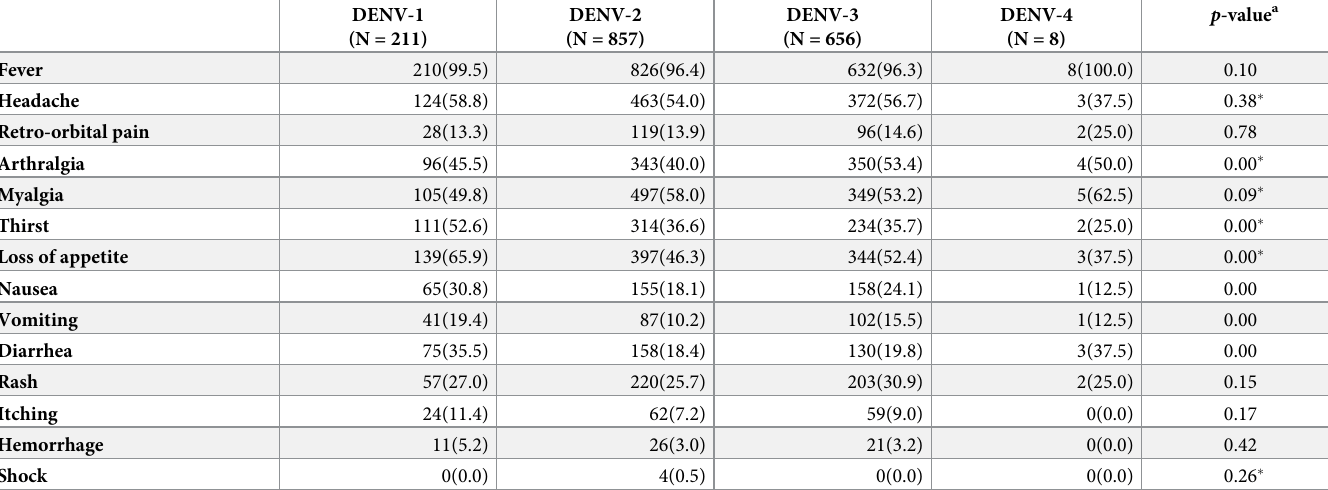
Table 6. Comparison of the clinical manifestations of dengue-infected patients with four dengue viral